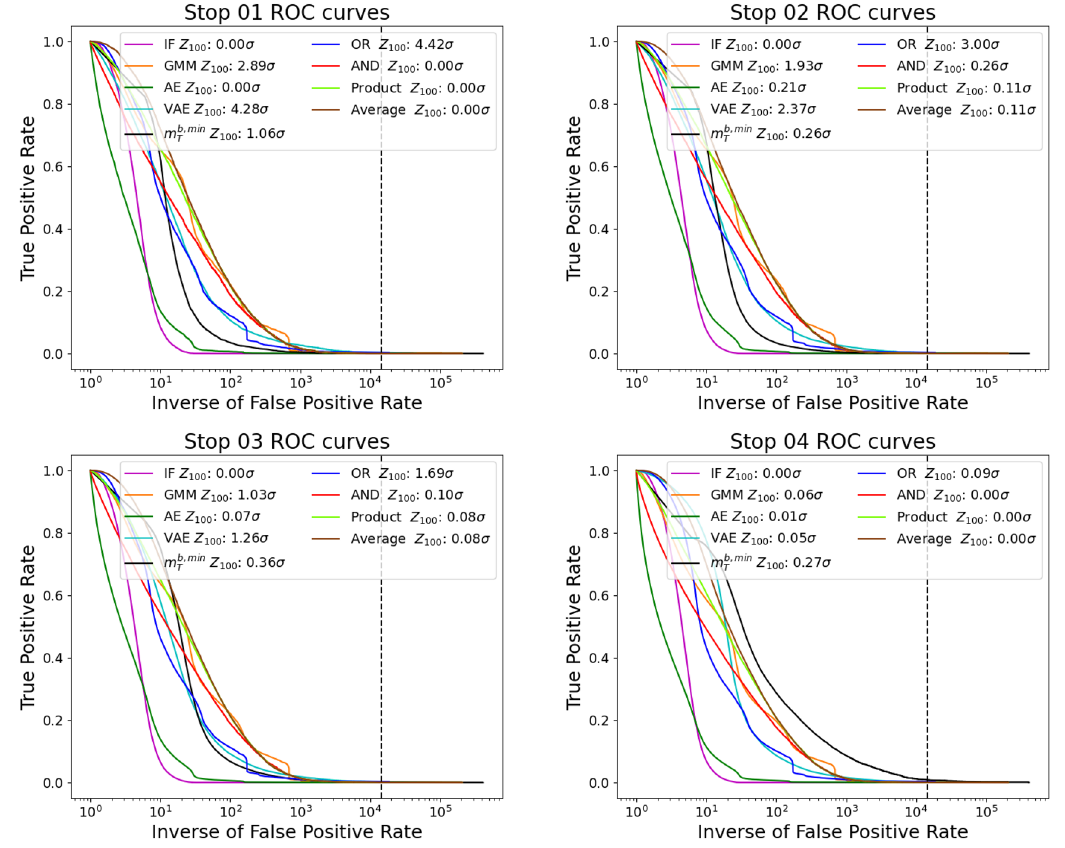
Figure 4 . ROC curves for the stop signals (table 1) for the algorithms applied on 4-vector repre- sentations. For further information see figure 3. The physical variable that is used here is m b , min